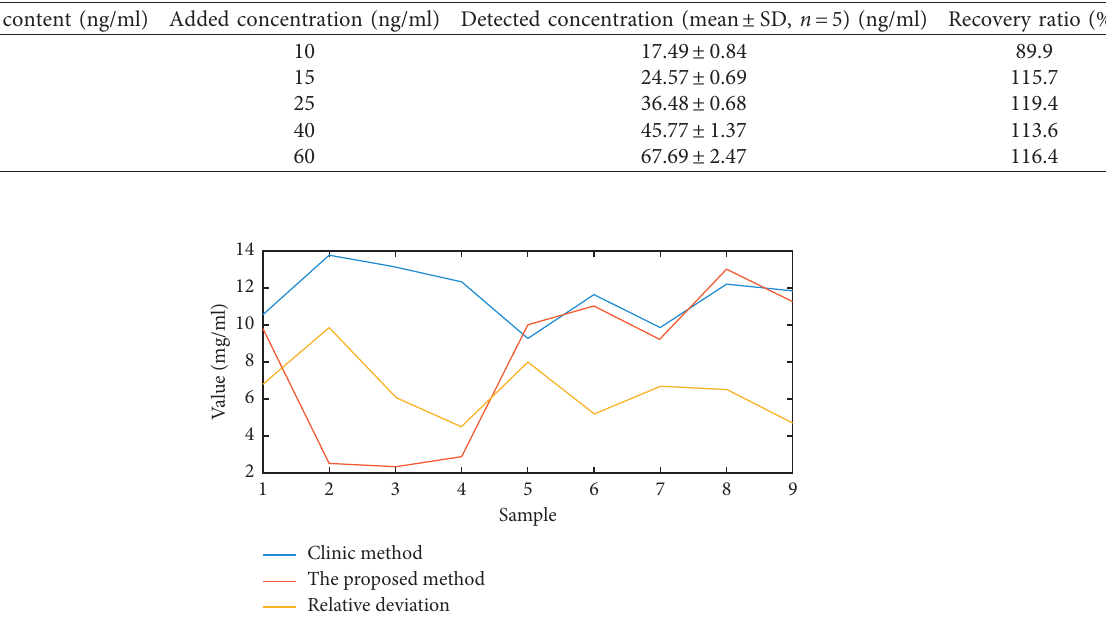
Figure 1: Comparison of electrochemiluminescence immunosensor with other immunoassay methods for the determination of